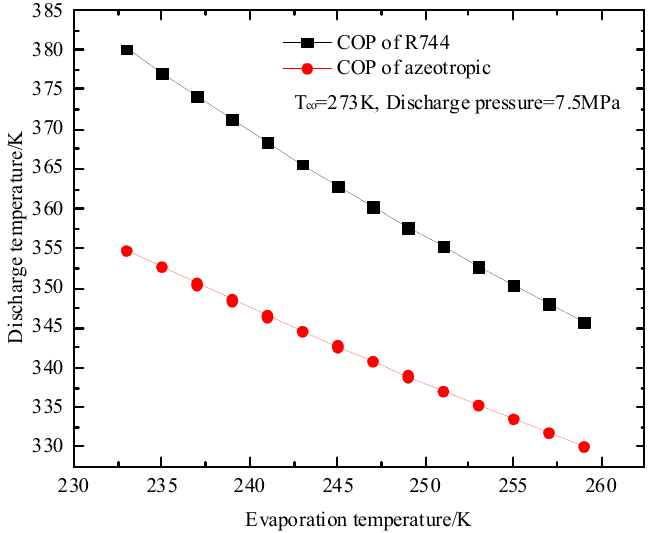
Figure 25. Comparison of discharge temperature of azeotropic refrigerant and R744 varies with evaporation temperature at different outlet temperatures of condenser.